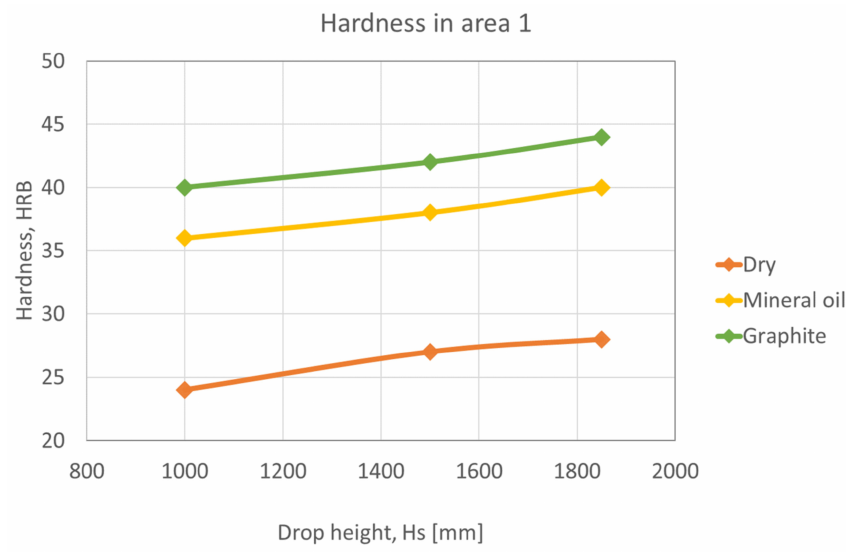
Figure 15. Variation of hardness as a function of ram drop height, in area